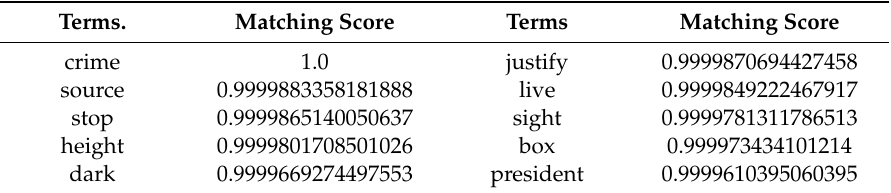
Table A7. Top terms for term crime.